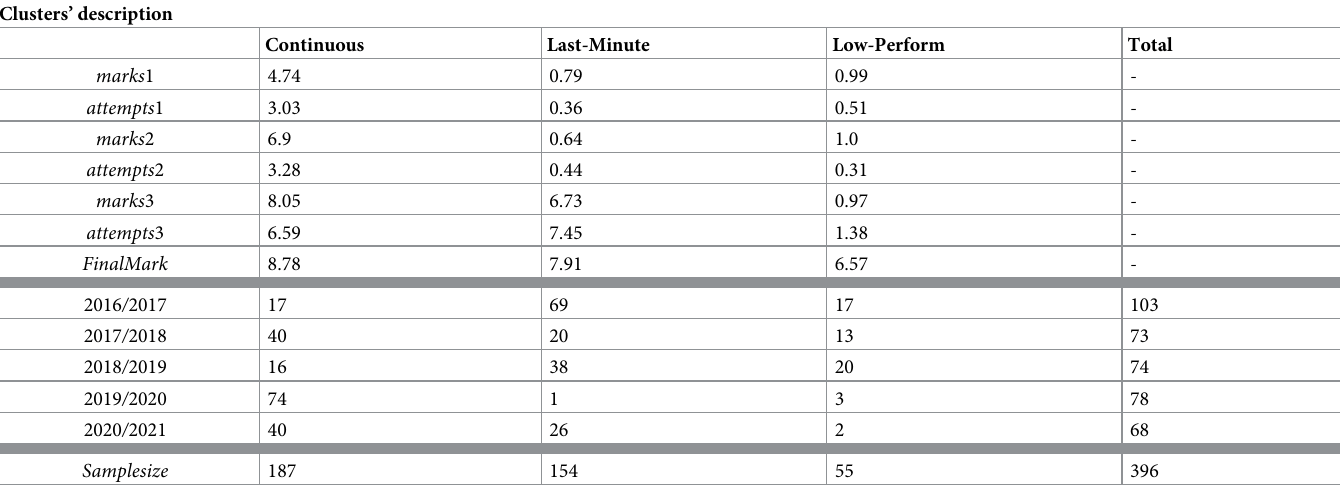
Table 2. Description of the three clusters using KMeans. Mean is used for the dataset attributes for each cluster. Clusters’ description